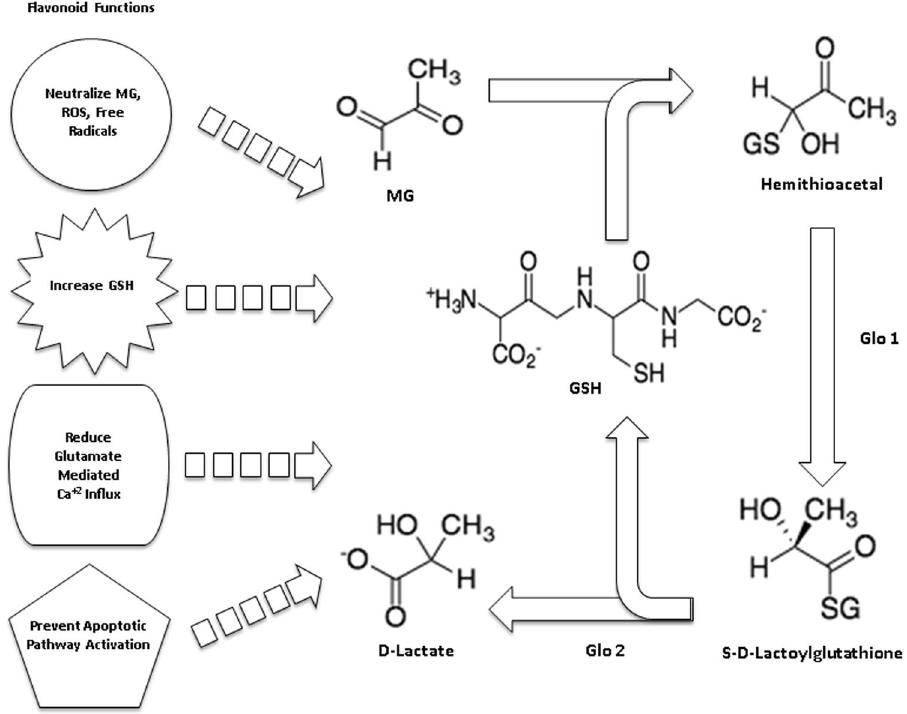
Figure 1. Scheme of flavonoid function in glyoxalase pathway. GSH reacts with MG to form a hemithioacetal. Glo-1 catalyzes the hemithioacetal into S-D-lactoylglutathione. Glo-2 catalyzes the final reaction, converting it into D-Lactate. Oxidized glutathione is used and recycled to its reduced